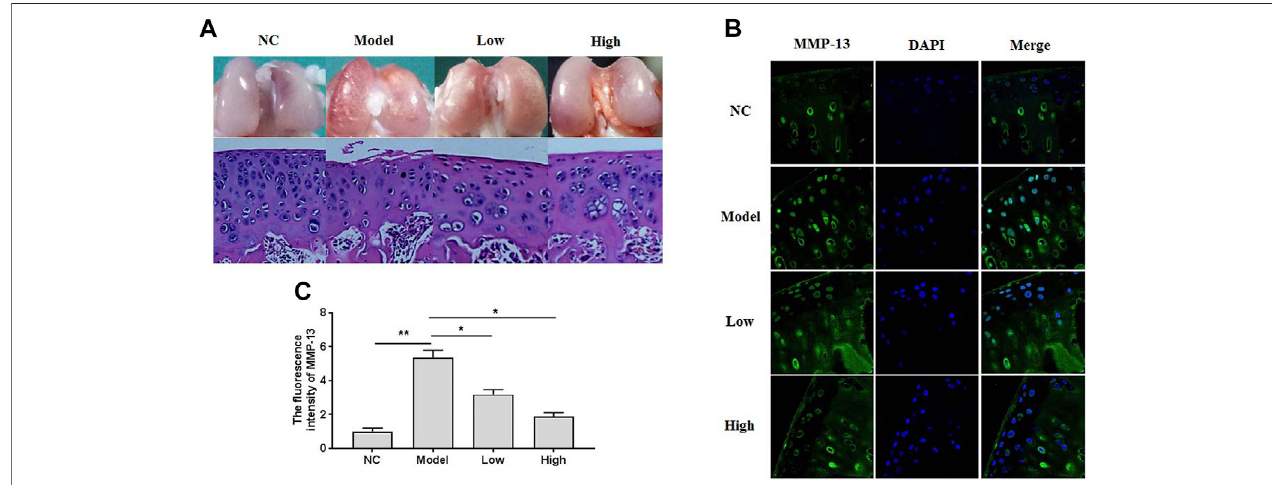
FIGURE1| Thegrossobservation,histomorphologicalexamination,andimmuno fl uorescenceassaysinthekneearticularcartilage. (A) Thegrossobservationand histomorphological examination (HE staining) of articular cartilage. (B) The immuno fl uorescence study of MMP-13 in cartilage. (C) The summary data of fl uorescence intensityofMMP-13 insitu .Allexperimentswereperformedintriplicateanddataarepresentedasthemean ± standarddeviation.* p < 0.05and** p < 0.01.NC,negative control; Model, the model group; Low, the group treated with XH (5.64 mg/kg); High, the group treated with XH (16.9